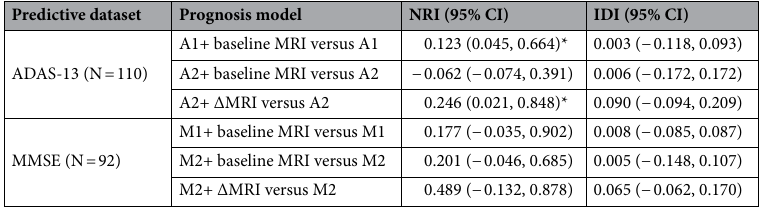
Table 3. Performance of prognosis models among high-risk patients with MCI. A1, ADAS-13 baseline Prognosis Model; A2, ADAS-13 longitudinal Prognosis Model; M1, MMSE baseline Prognosis Model; M2, MMSE longitudinal Prognosis Model. ADAS-13, Alzheimer Disease Assessment Scale Cognitive 13 items; MMSE, Mini mental state examination; NRI, Net Reclassification Improvement; IDI, Integrated Discrimination Improvement. Values based on the following assumptions: Risk of event = 10%. *The indices are statistically